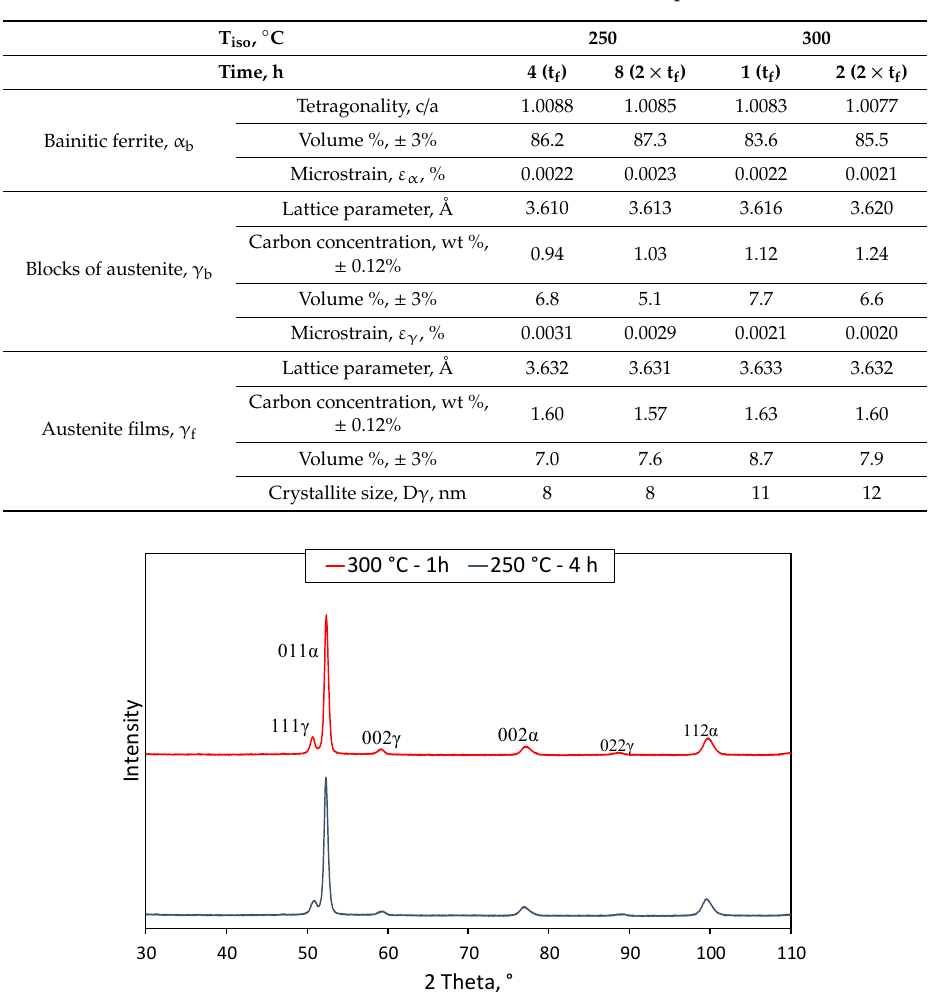
Table 1. Results of the Rietveld refinement of XRD patterns.